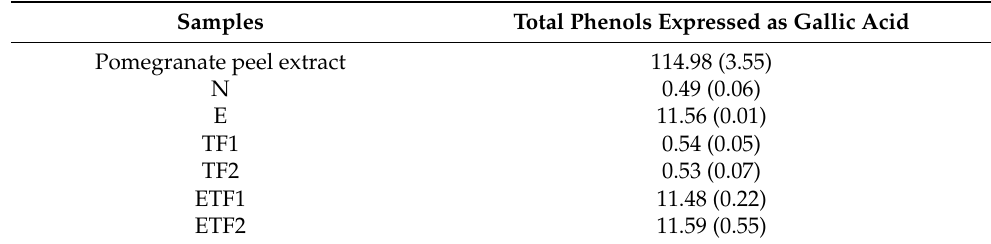
Table 1. Mean (standard deviation) of the concentration of phenolic compounds (mg g −1 ) in samples. Samples